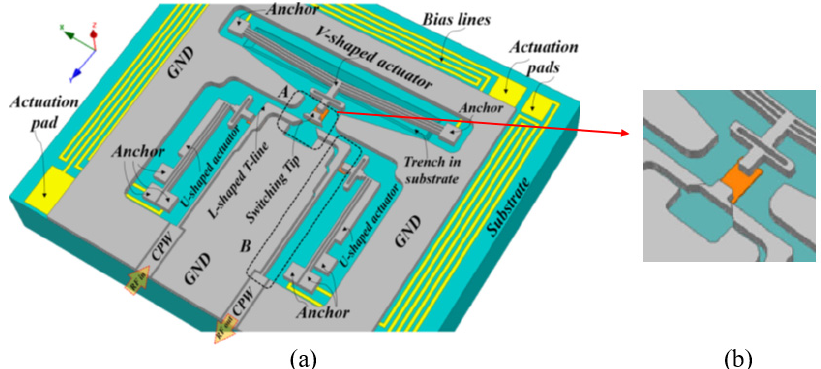
Figure 13. The electrothermal actuated bistable MEMS switch (Zolfaghari P et al. 2018 [13]): ( a ) the schematic view; ( b ) the close-up of the switching tip.